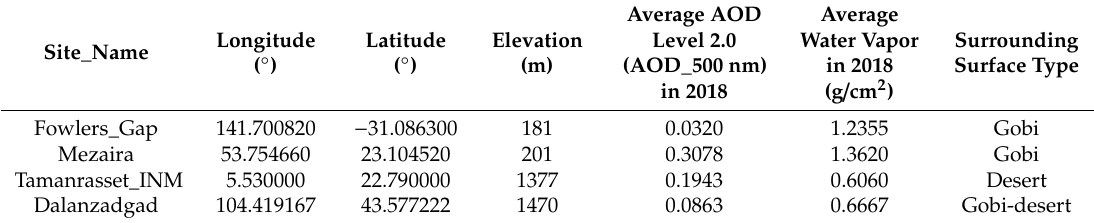
Figure 2. The bidirectional reflectance distribution factor (BRDF) fitting accuracy comparison between the Stalylor–Suttles and the kernel BRDF models at four different AErosol Robotic NETwork (AERONET) sites around the world ( a ) Fowlers_Gap, ( b ) Mezaira, ( c ) Tamanrasset_INM, and ( d ) Dalanzadgad. Table 2. The information of the four AERONET sites (Fowlers_Gap, Mezaira, and Tamanrasset_INM, and Dalanzadgad). (This information comes from https://aeronet.gsfc. nasa.gov/).